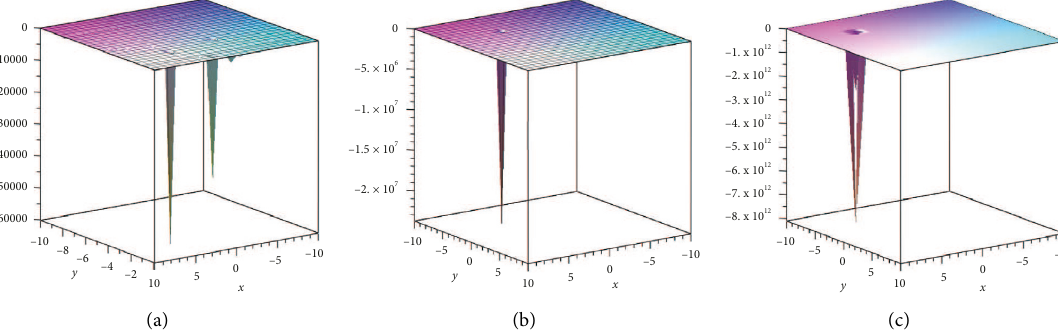
Figure 4: Evolution of equation (48). (a) Perspective view of the wave at t � 0. (b) Perspective view of the wave at t � 1. (c) Perspective view of the wave at t �